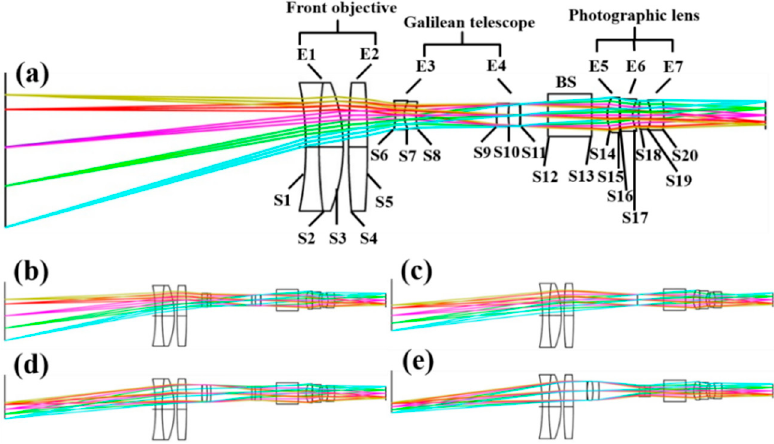
Figure 3. Layout of the non-coaxial DSLM optical system. The magnifications of the system are ( a ) 6×, ( b ) 10×, ( c ) 16×, ( d ) 25×, and ( e ) 40×. BS: Beam Splitter.